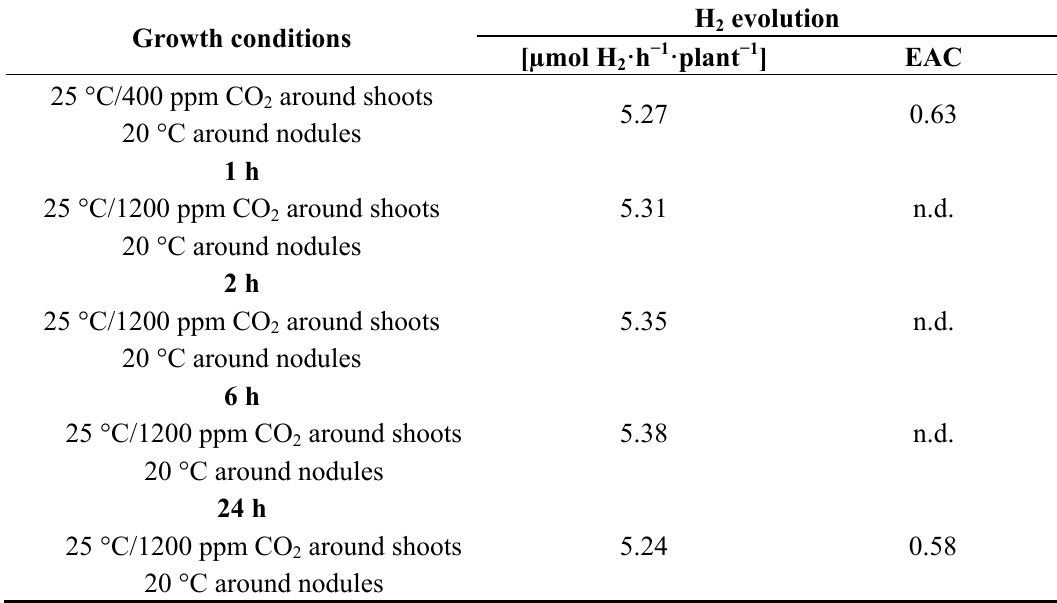
Table 2. H evolution of M . truncatula nodules after short-term increase of the CO 2 concentration around shoots. Data are given as means of 8 replicates. The electron allocation coefficient (EAC, relative efficiency of nitrogenase) was measured at the beginning and the end of the experiment. Data were compared statistically (within a column) between the points in time of the analysis but showed no significant differences ( Tukey ’s test, p < 0.05, n = 10; comparison of the EAC by the t -test, p < 0.05, n =